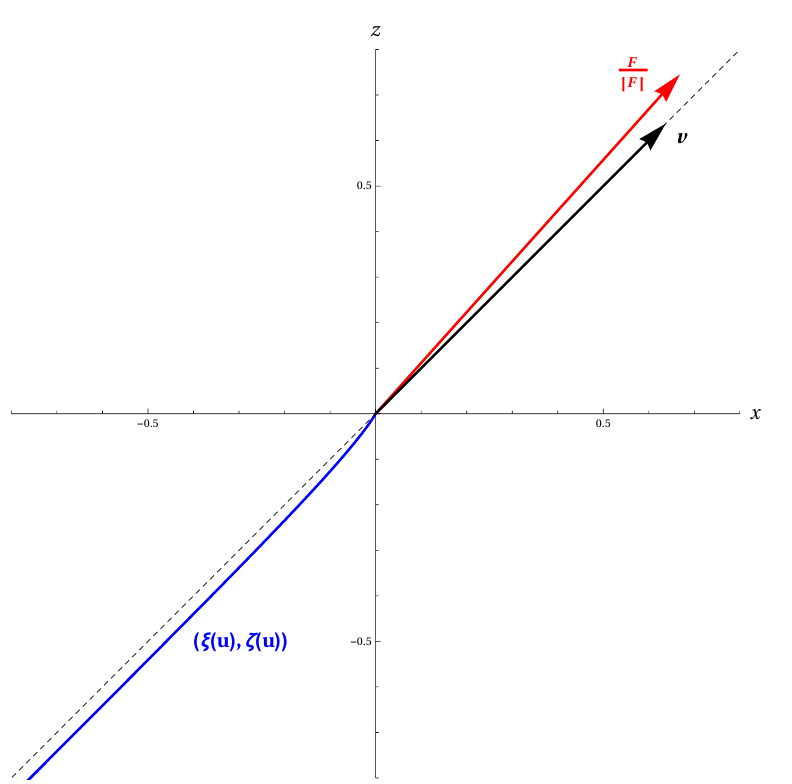
Figure 12 . Projection of the string con(cid:12)guration onto the xz -plane and the corresponding force on the quark in the anisotropic background for a velocity v = 0 : 9, an angle of (cid:18) = 45 (cid:14) , a= ( (cid:25)T ) = 2, and c =